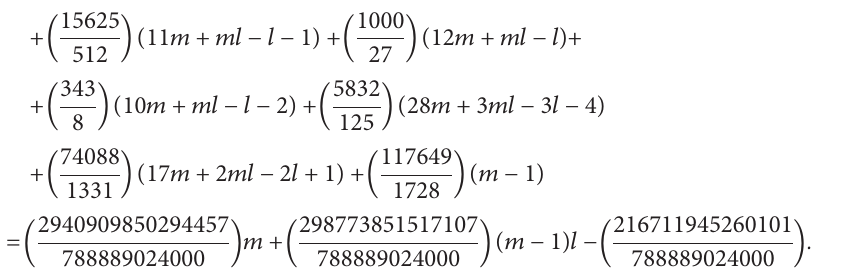
Figure 10: Comparison of CL l of the